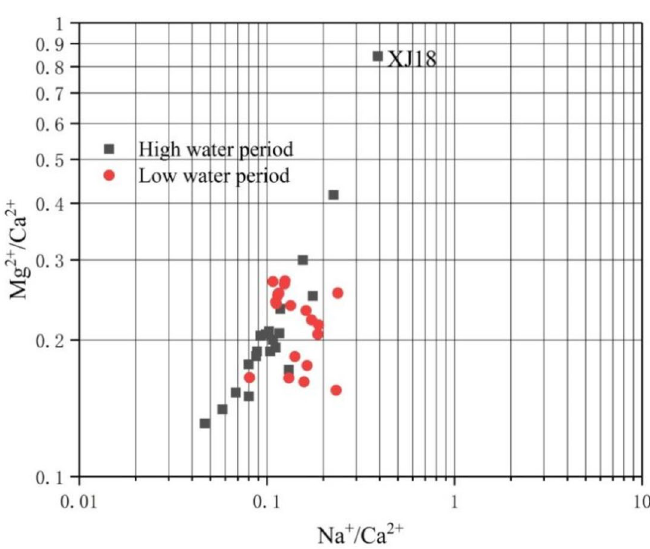
Figure 2. The relationship between Mg 2+ /Ca 2+ and Na + /Ca 2+ ratios in river water during the high (grey squares) and low (red circles) water periods on a log–log